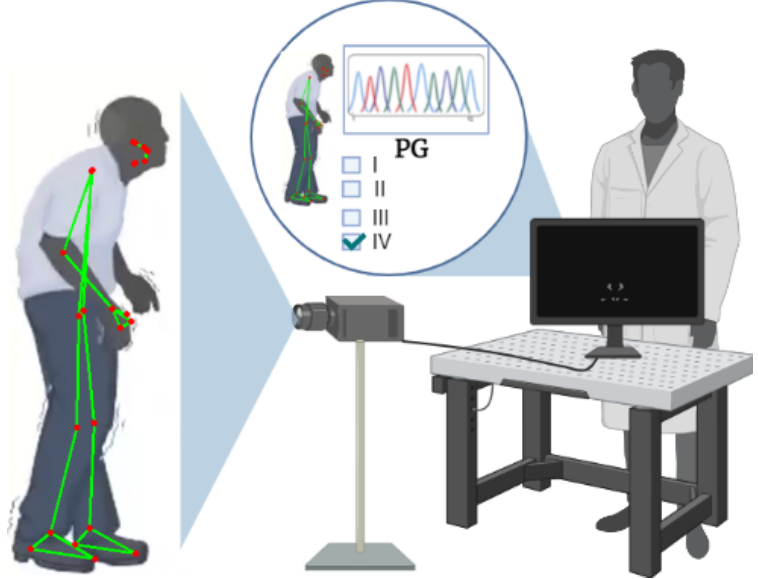
Figure 1. Vision-based system for stage classification of Parkinson’s disease based on gait analysis. Created with